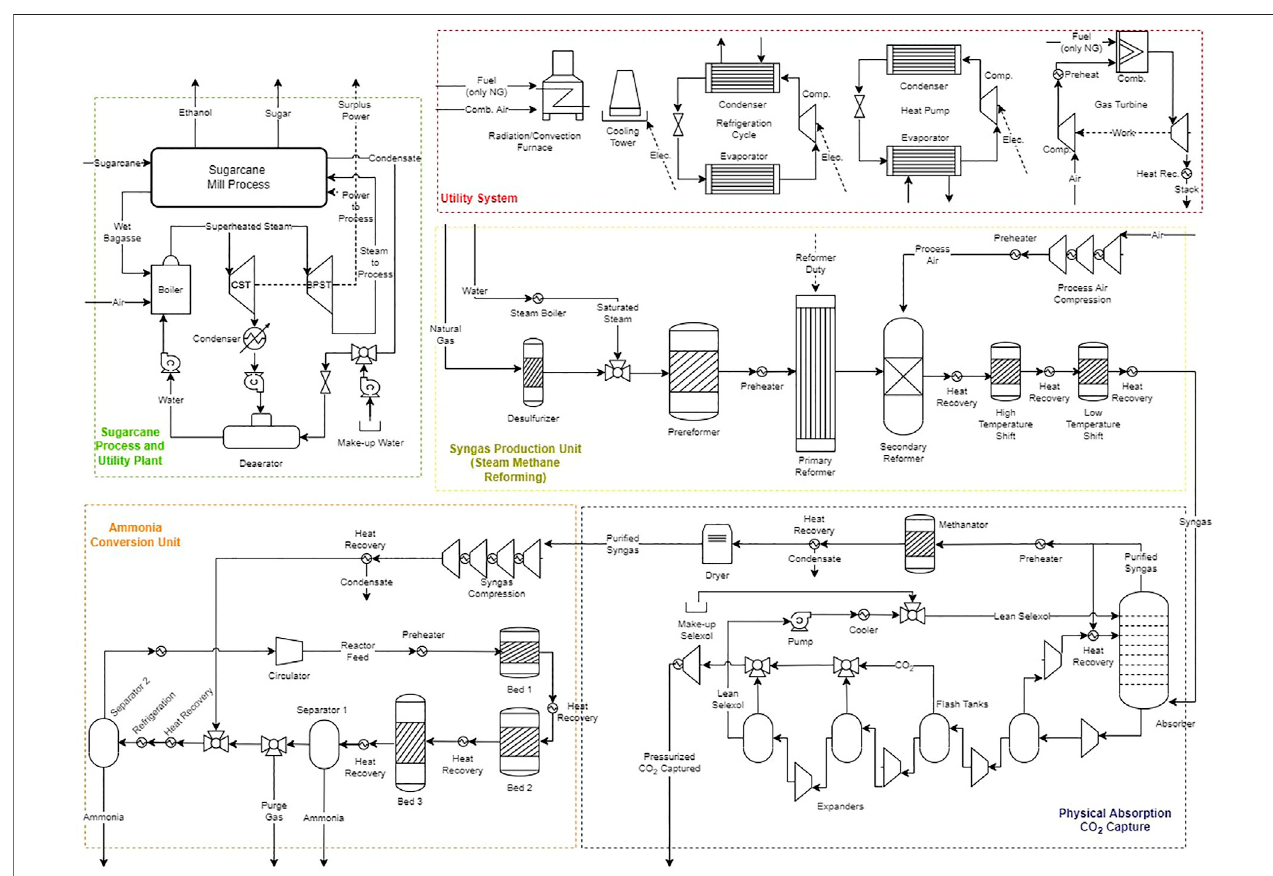
FIGURE 1 | Flowsheet of the conventional scenario, considering a standalone sugarcane mill and a conventional ammonia plant. BPST, Backpressure steam turbine; CST, Condensing steam turbine.